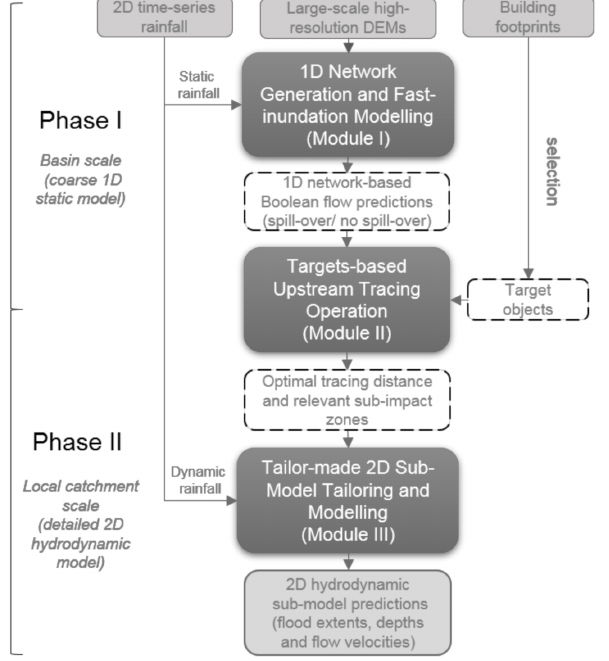
Figure 1. Illustration of the sub-model approach. In the central column, shaded boxes represent three major modules; light grey boxes are required inputs and final outputs; dashed-line boxes are intermediate data between different modules. Phase I and Phase II (left side) represent the two major phases, where different levels of modelling complexities (1D static/2D hydrodynamic model) are applied at different scales (basin/local catchment scale) to achieve a holistic computational efficiency via a GIS-based multi-scale simulation framework.